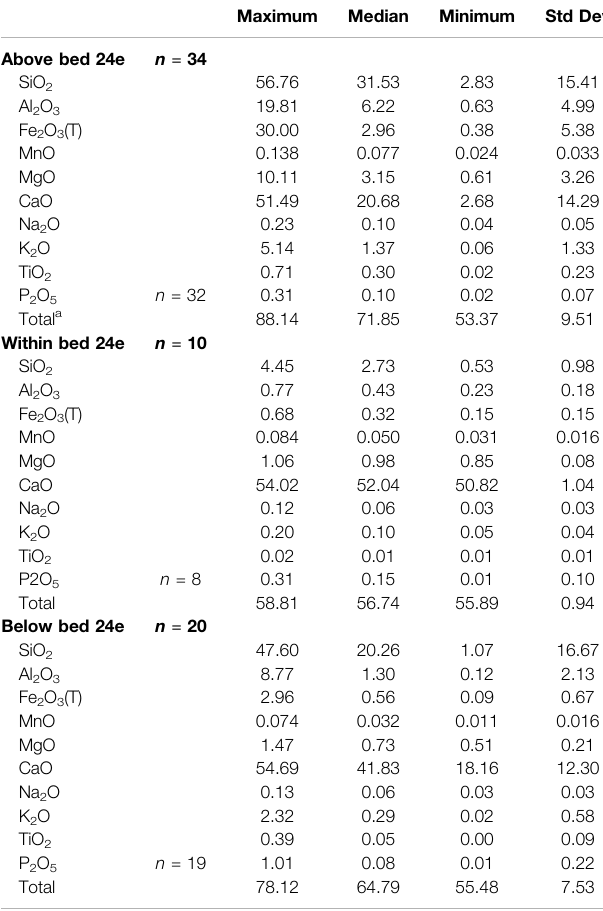
TABLE 1 | Summary of whole rock major element